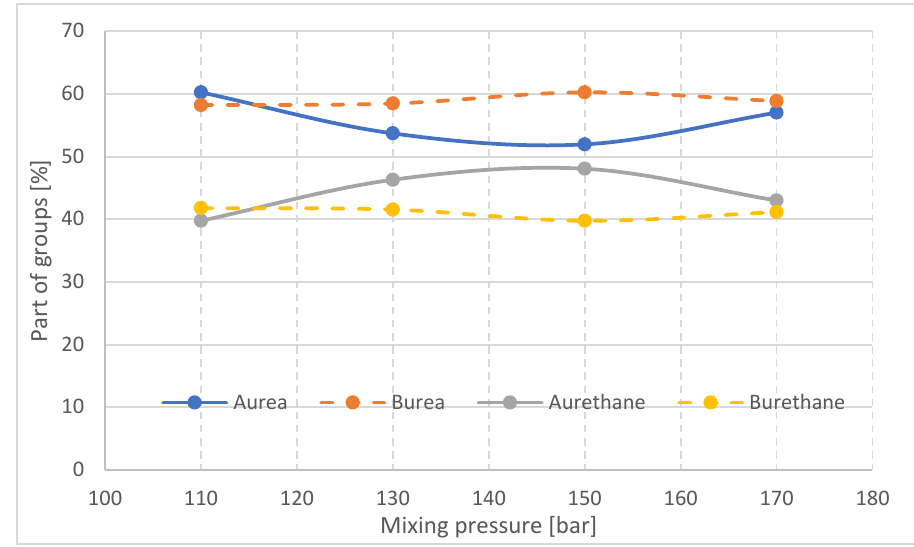
Figure 17. Proportion of urea and urethane groups in rigid foam segments in samples taken from parts A and B of foam blocks.